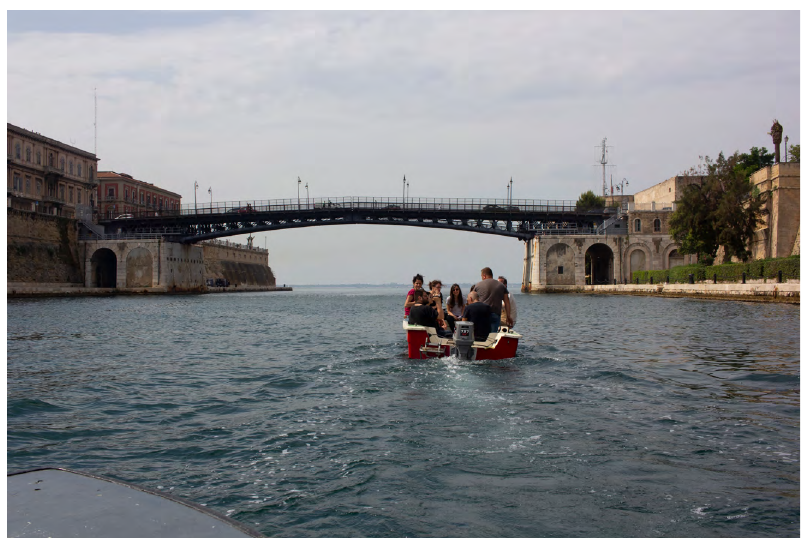
FIG. 1 Exploration by sea between the Mare Piccolo and Mare Grande of Taranto, Photo by Amina